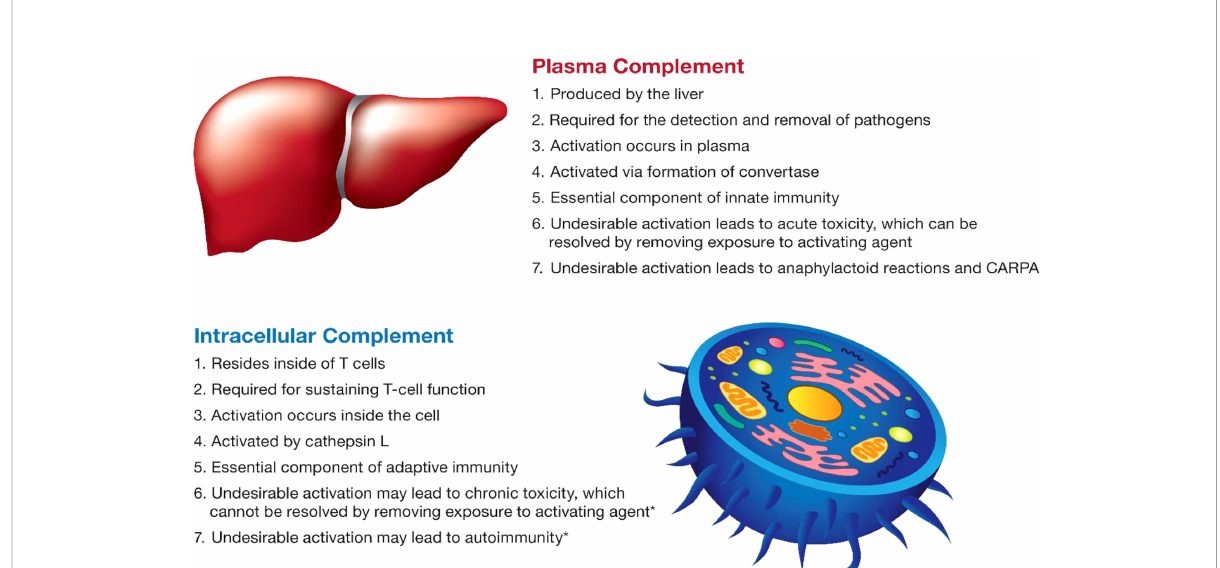
FIGURE 3 The main characteristics of the complement system. The main characteristics of plasma and intracellular complement are summarized. The intracellular complement system is discussed in the fi gure in the context of T lymphocytes due to a better understanding of its function in the currently available literature. The intracellular complement system has also been detected in other cell types; its role in other cells is less understood and, therefore, not mentioned in the fi gure. Statements highlighted with an asterisk (*) were hypothesized based on the role of lymphocytes in which the intracellular complement system was described; experimental veri fi cation is still required for these statements and represents one of the future directions of research in this fi